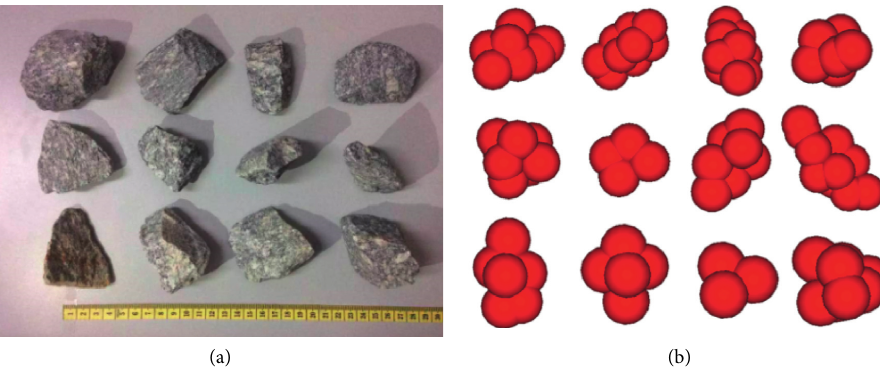
Figure 1: Ballast particles and constructed elements of ballast in DEM. (a) Real ballast. (b) DEM model of ballast particles.